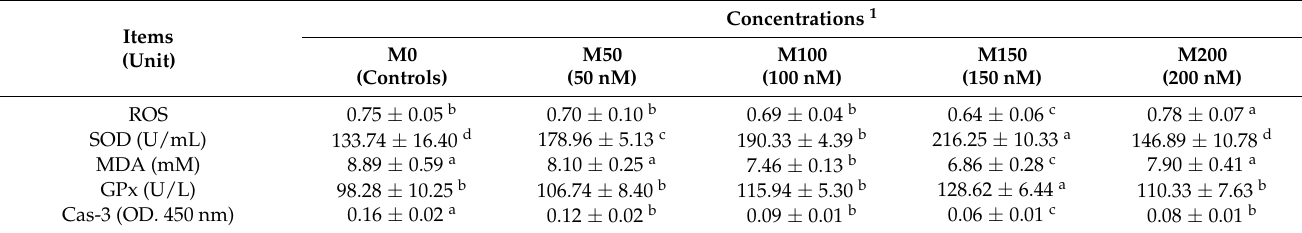
Table 3. Influence of different concentrations of mitoquinone (MitoQ) on the antioxidant capacities of post-thawed rooster